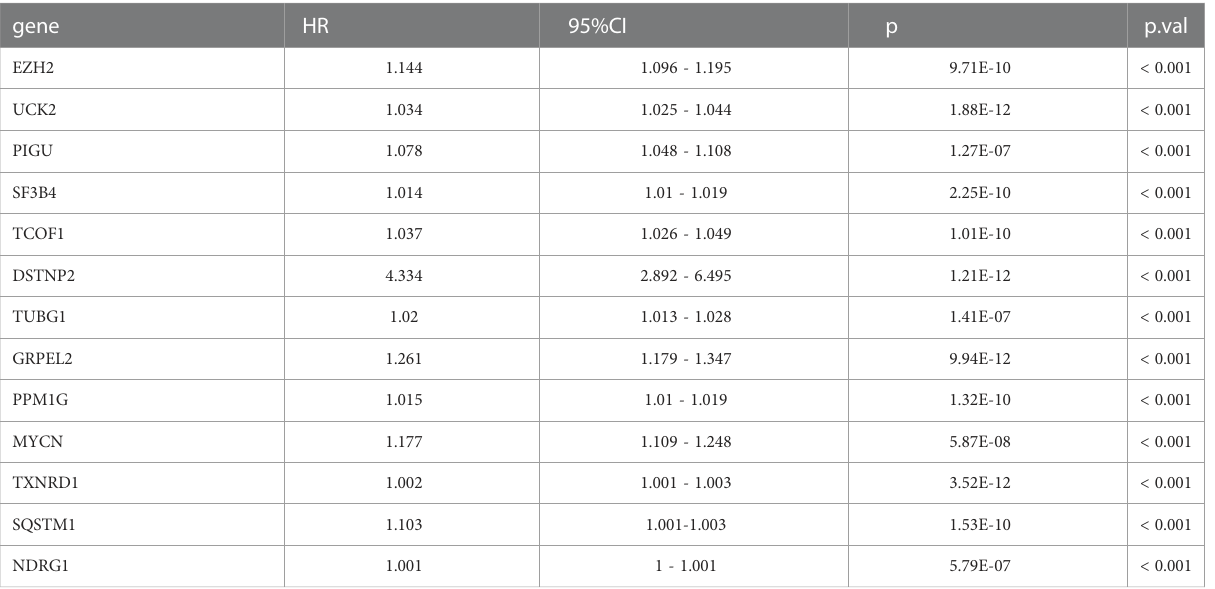
TABLE 2 Hazard ratio of 14 hub